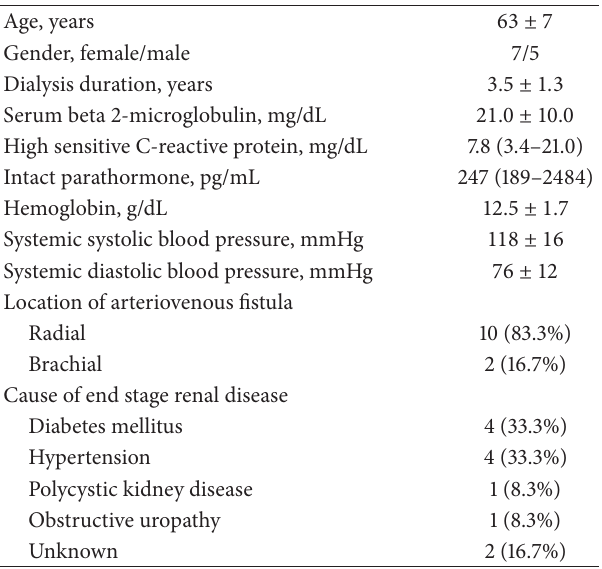
Table 1: Characteristics of 12